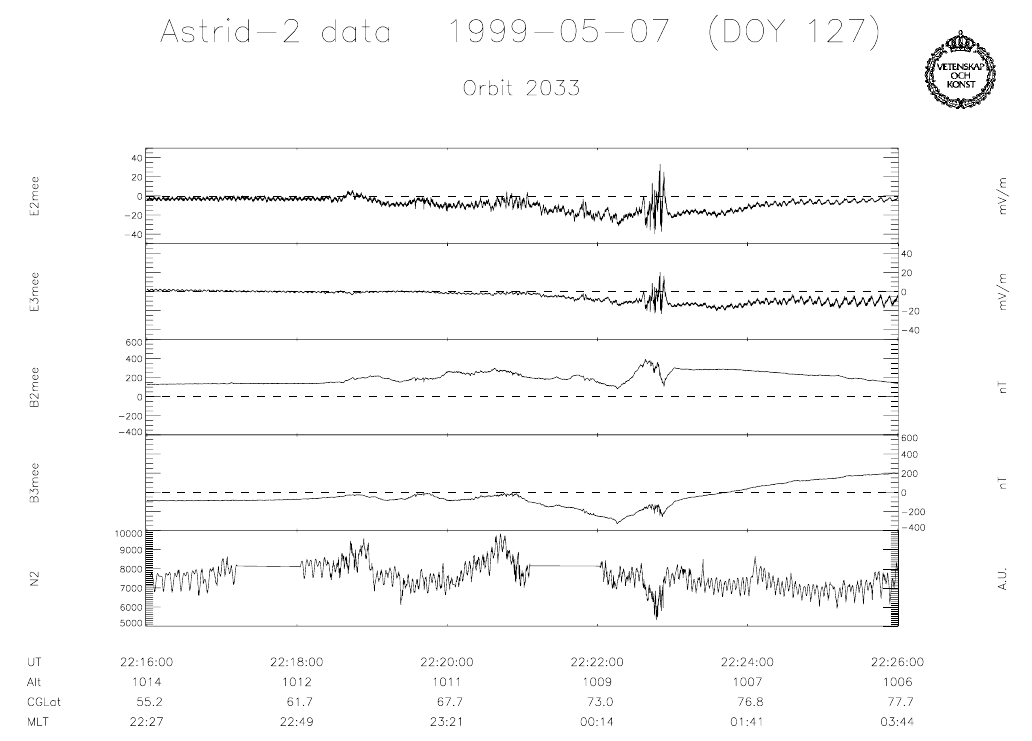
Fig. 5. Electric field, magnetic field and plasma density measured by Astrid-2 for the same time interval as in Fig. 4. The panels show from top to bottom the geomagnetic east and west components of the electric field and of the magnetic field, respectively, and the plasma density measured by the Langmuir probe.